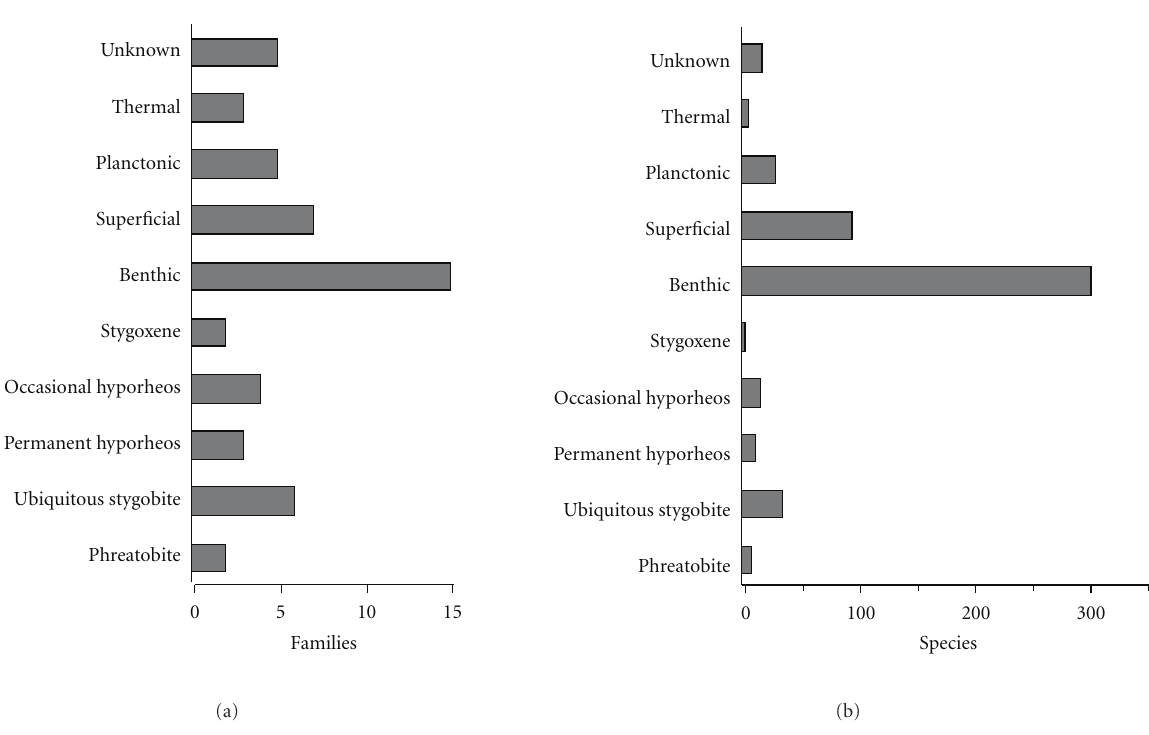
Figure 2: Functional classification for South-American (south of latitude S 15) Hydrachnidia, in numbers of families and species in each